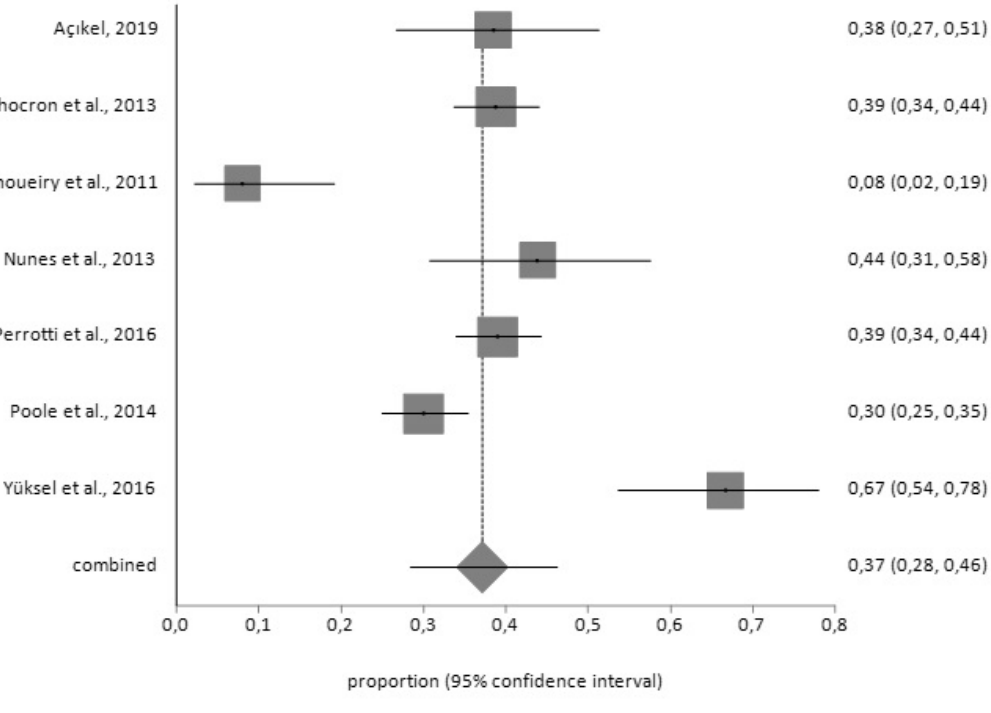
Figure 4. Forest plot for pre-CABG depression using Beck Depression Inventory (BDI).